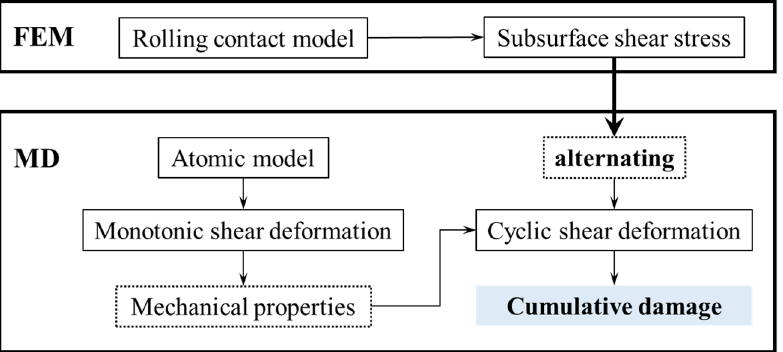
Figure 1. Research framework of this paper. FEM, Finite element method. MD, Molecular dynamics.